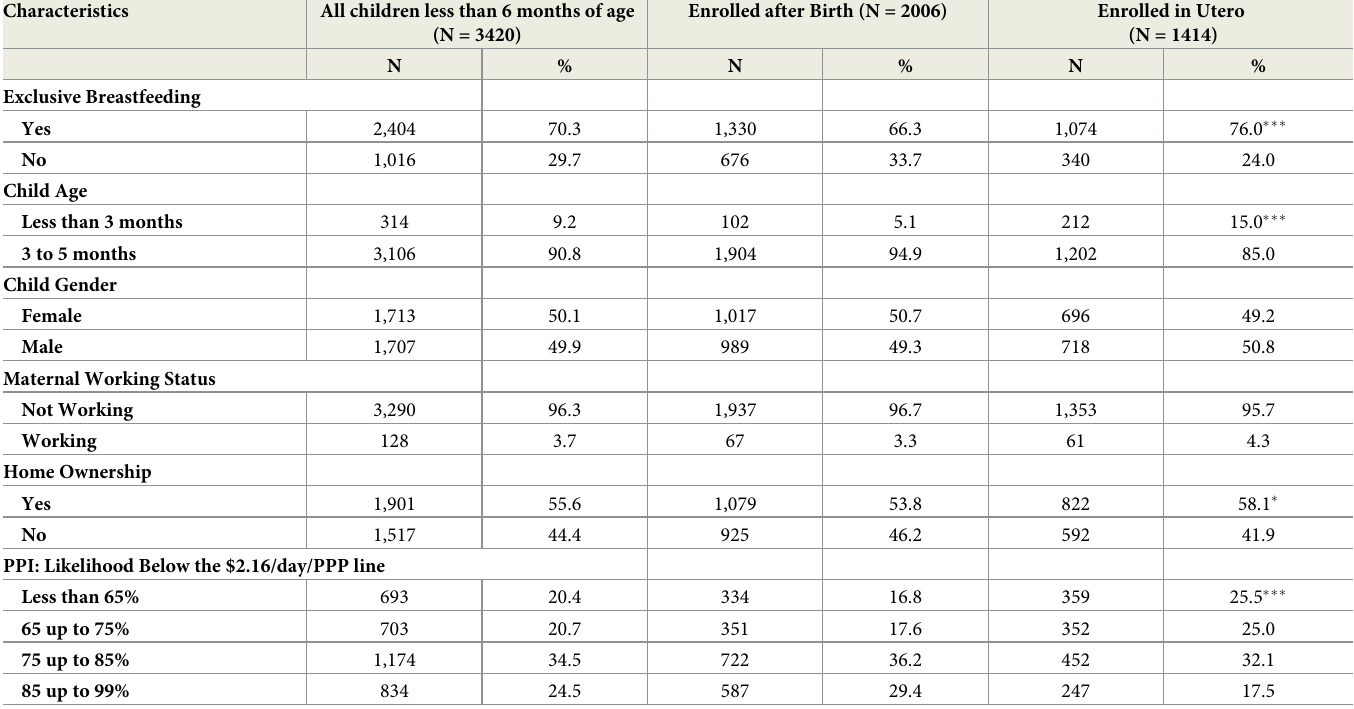
PPI, Progress out of Poverty Index; PPP, Purchasing Power Parity. Pearson chi-square for categorical variables comparing children screened in utero to children screened after birth (cid:3) P-value: (cid:20) 0.05 (cid:3)(cid:3)(cid:3) P-value: (cid:20)